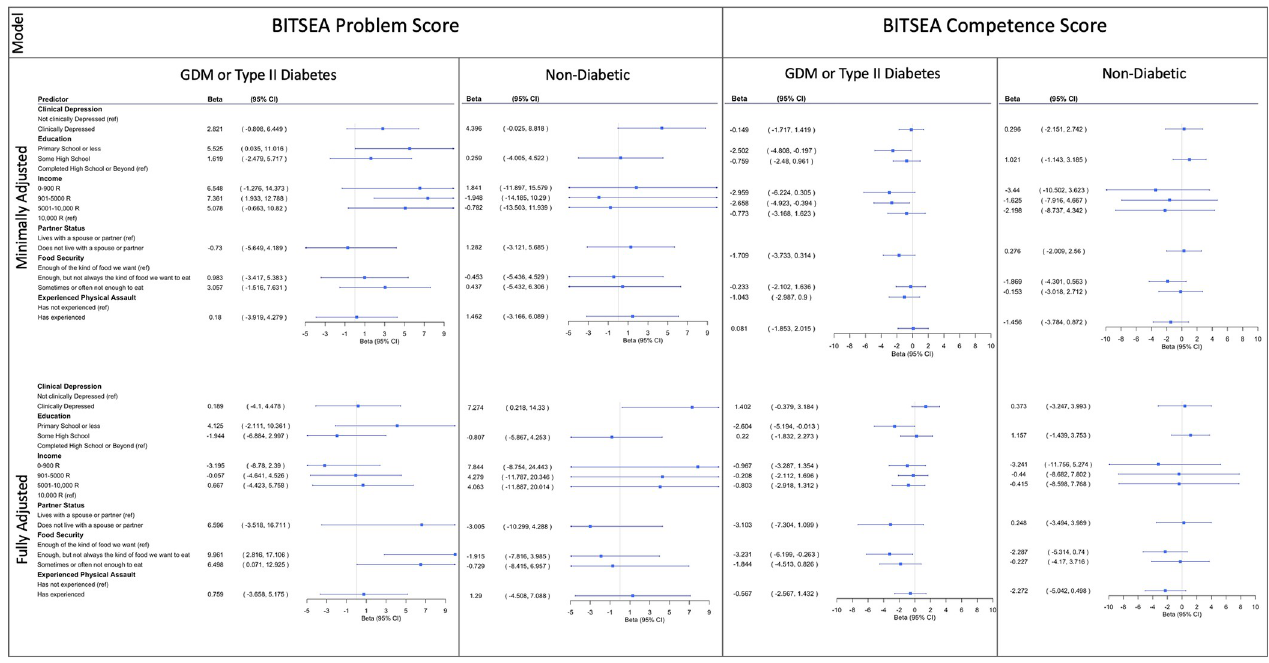
Fig 4. Stratified by diabetes betas and 95% CI for correlates of BITSEA Problem (left) and Competence Score (right). Minimally adjusted model was adjusted for maternal age. Fully adjusted model was adjusted for maternal age as well as the other maternal experiences. Maternal physical assault and income were analyzed in separate